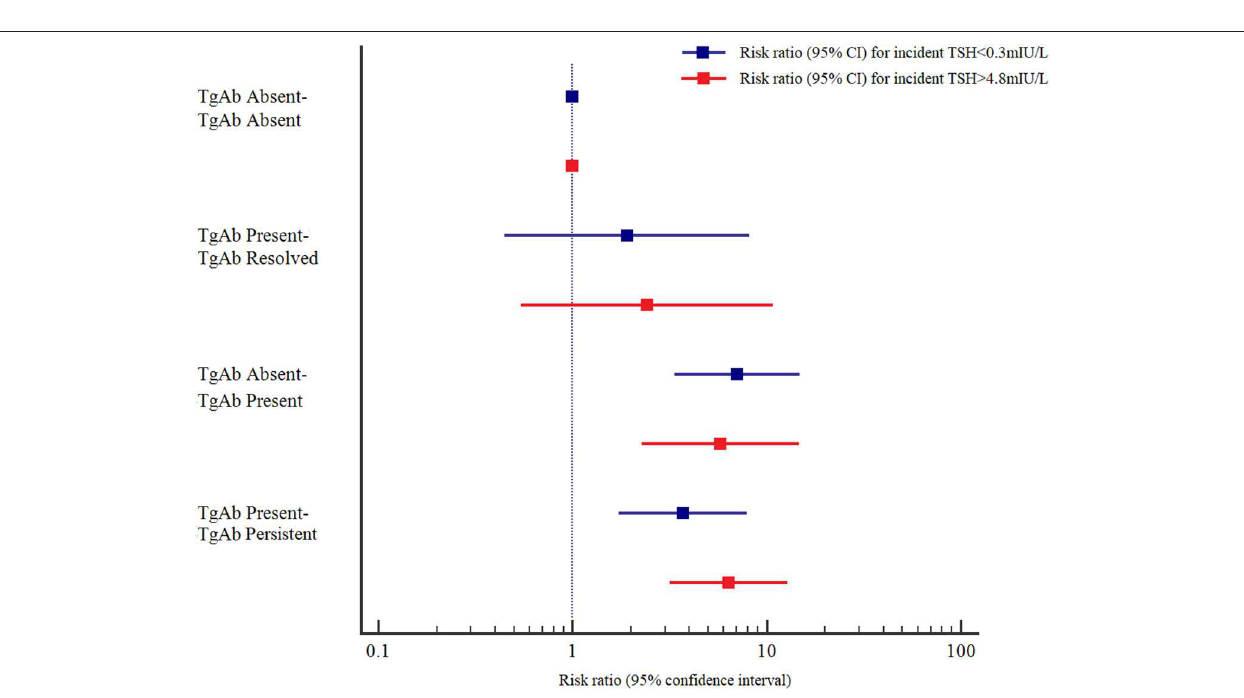
Frontiers in Endocrinology |